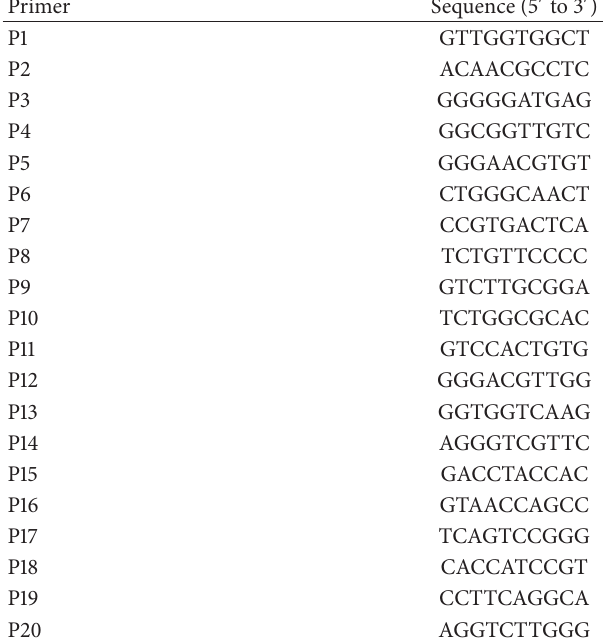
Table 1: Primers used for random amplified polymorphic